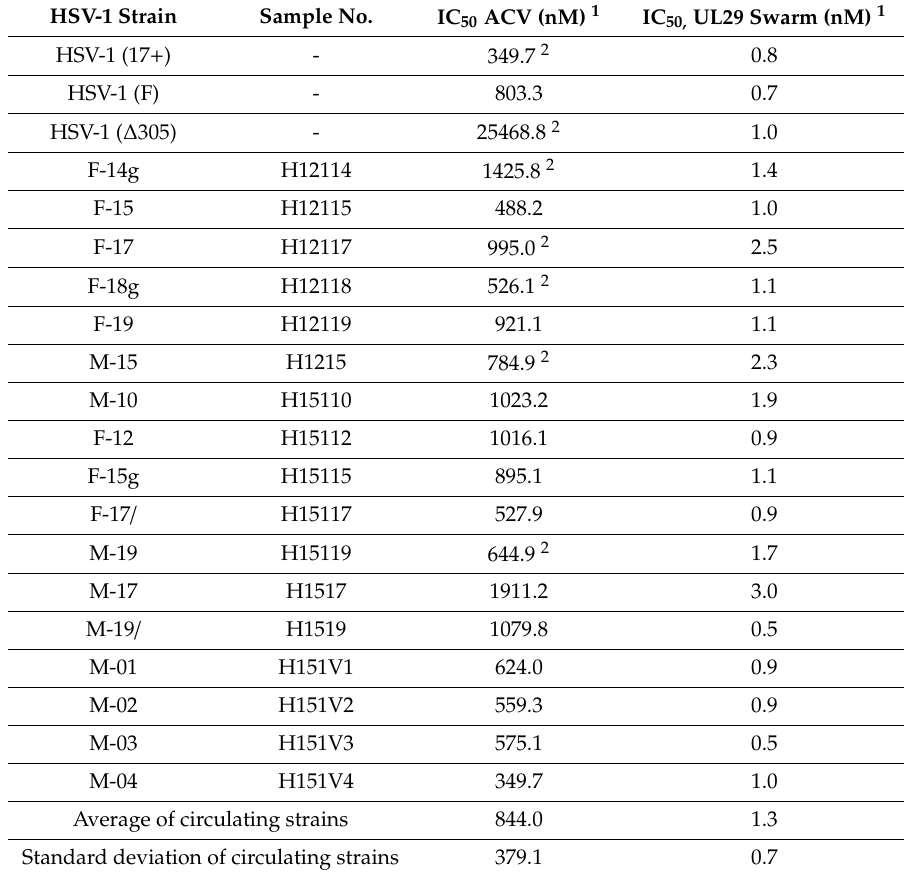
Table 2. Finnish clinical HSV-1 isolates and their sensitivities (IC 50 ) to ACV or to UL29 siRNA treatment.